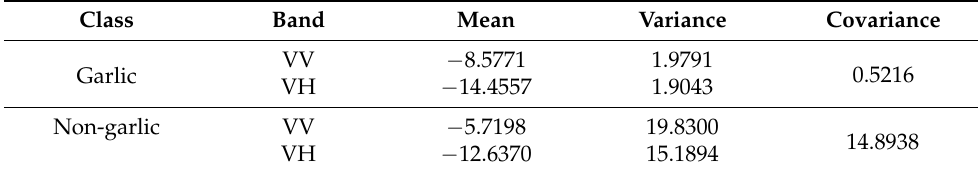
Table 6. Characteristics of bands VH and VV in dataset